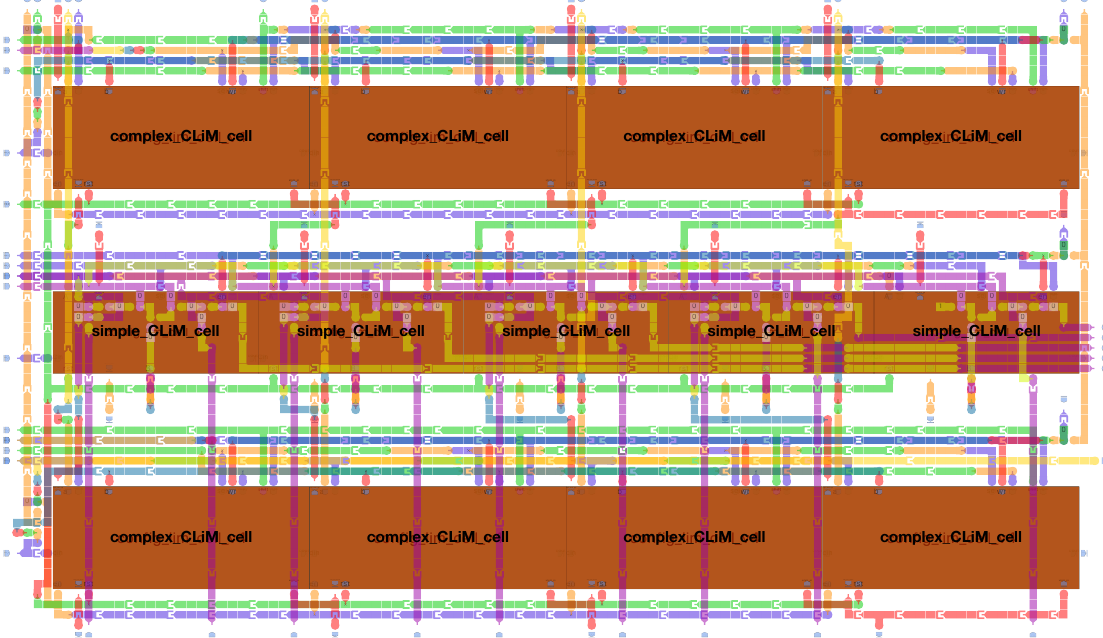
Figure 21. Small pNML-based version of the CLiM